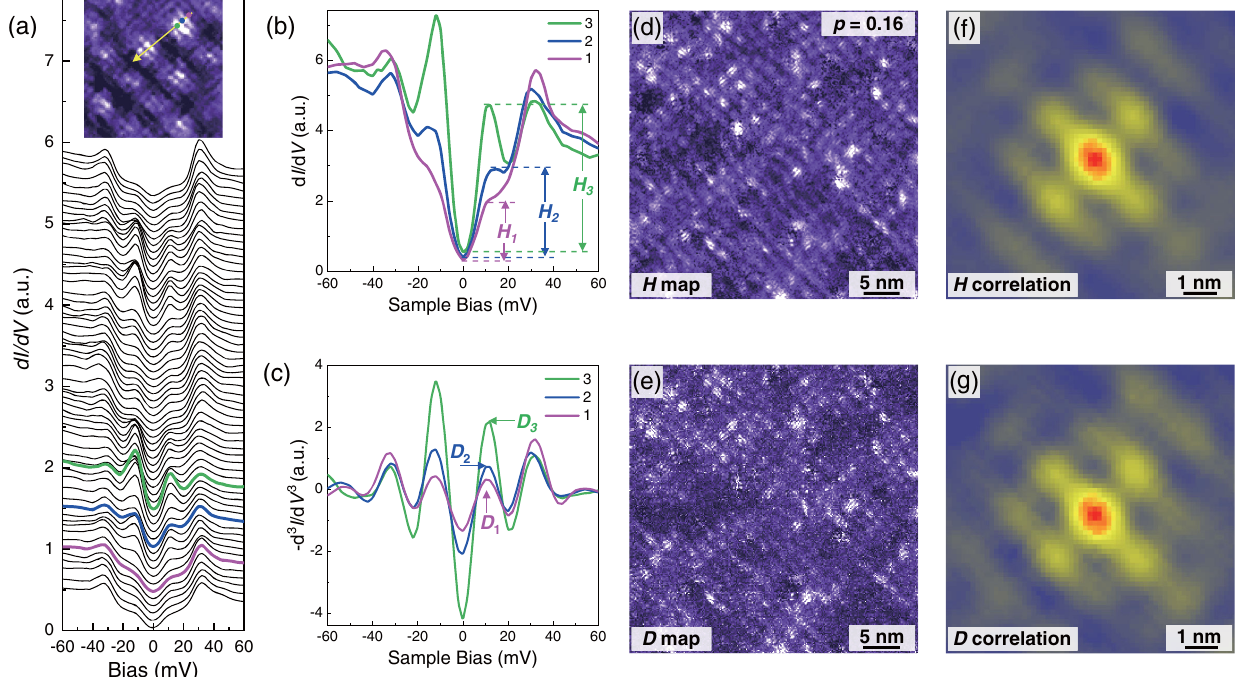
FIG. 6. The PDW features in the optimally doped sample. (a) The spectra taken along the yellow arrow in the inset dI=dV map. (b) Three representative curves taken on the colored spots in (a), and the gap depth H of each curve is illustrated by the dashed line. Þ value at V ð r Þ ∼ 10 mV shows the sharpness of the local SC (c) The D ð V Þ ¼ − d 3 I=dV 3 curves of the three curves in (b). The D ð V sc sc coherence peak. (d) The H map exhibits the distribution of local gap depth H ð r Þ . (e) The D map displays the spatial distribution of SC coherence peak sharpness at each location. (f),(g) The intensity distribution of cross-correlation C ð R Þ between the H map and D map with the dI=dV ð 10 mV ; r Þ map in Fig. 1(b). The maximum value at the center indicates a positive